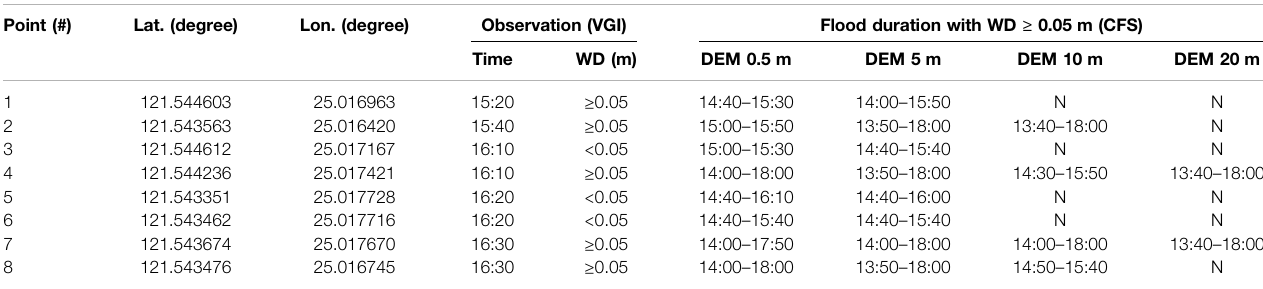
TABLE 3 | Comparison between CFS and VGI results. Point (#) Lat.